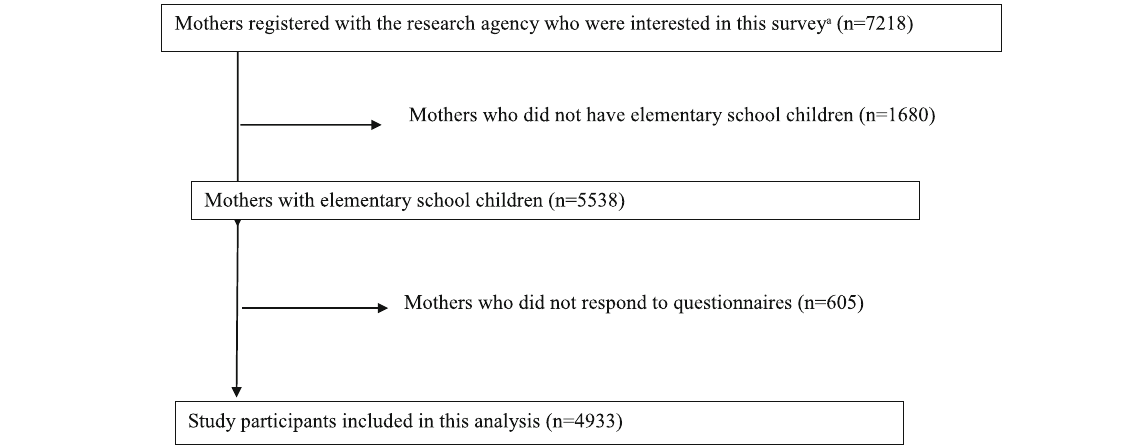
Fig. 1 Flow diagram of study participants. Superscript small letter “ a ” indicates that mothers were recruited through e-mail and the website of a research